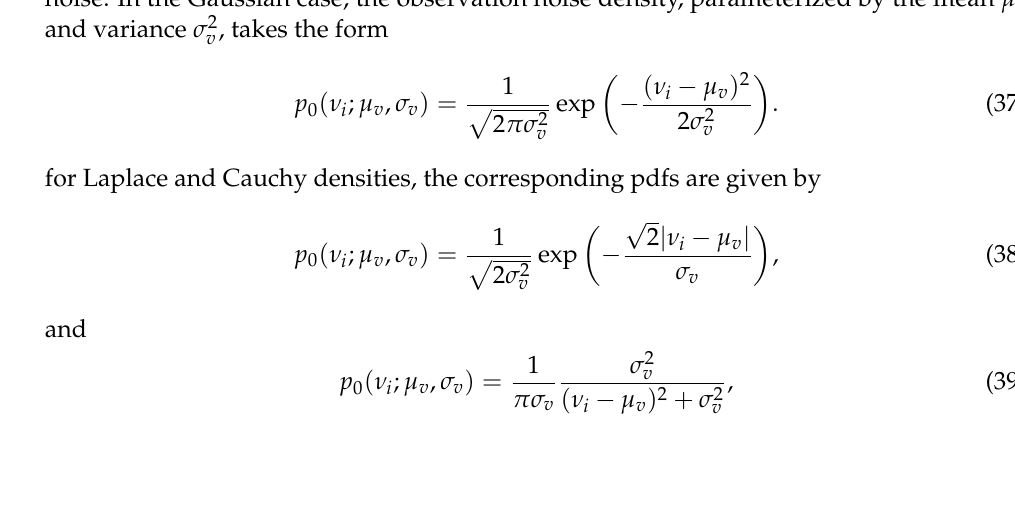
Figure 4. ( a ) Layout of an array of sensors for measuring pressure (denoted by p m and heating rate (denoted by t m , i = 1, . . . ,8) on the heat shield of a Mars entry vehicle. ( b ) An i alternative view of the sensor locations geometry looking in the direction of the positive x